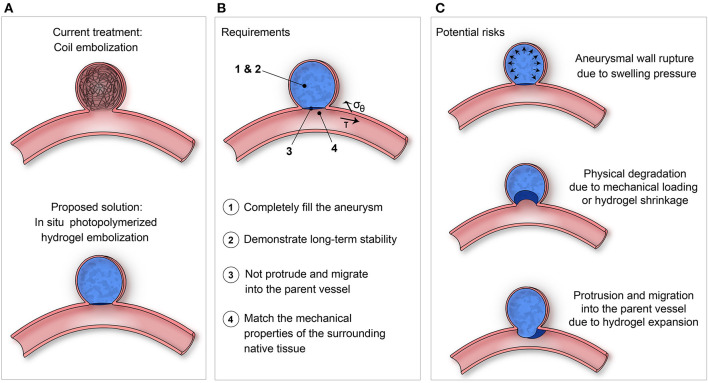
(A) Proposed solution of using in situ photopolymerized hydrogel for intracranial aneurysm embolization instead of coil embolization. (B) Requirements and (C) Potential risks to be evaluated of such a solution.